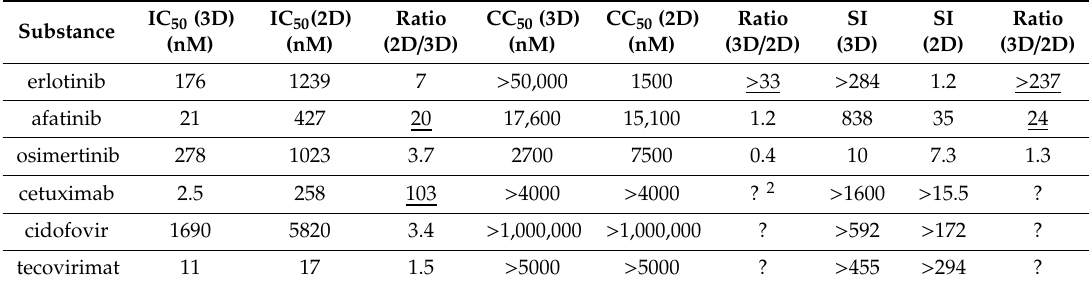
Table 1. IC 50 s, half-maximal cytotoxic concentration (CC 50 )s and selectivity indices (SIs) of tested antiviral substances in CPXV infected primary 3D and 2D cultures 1 .